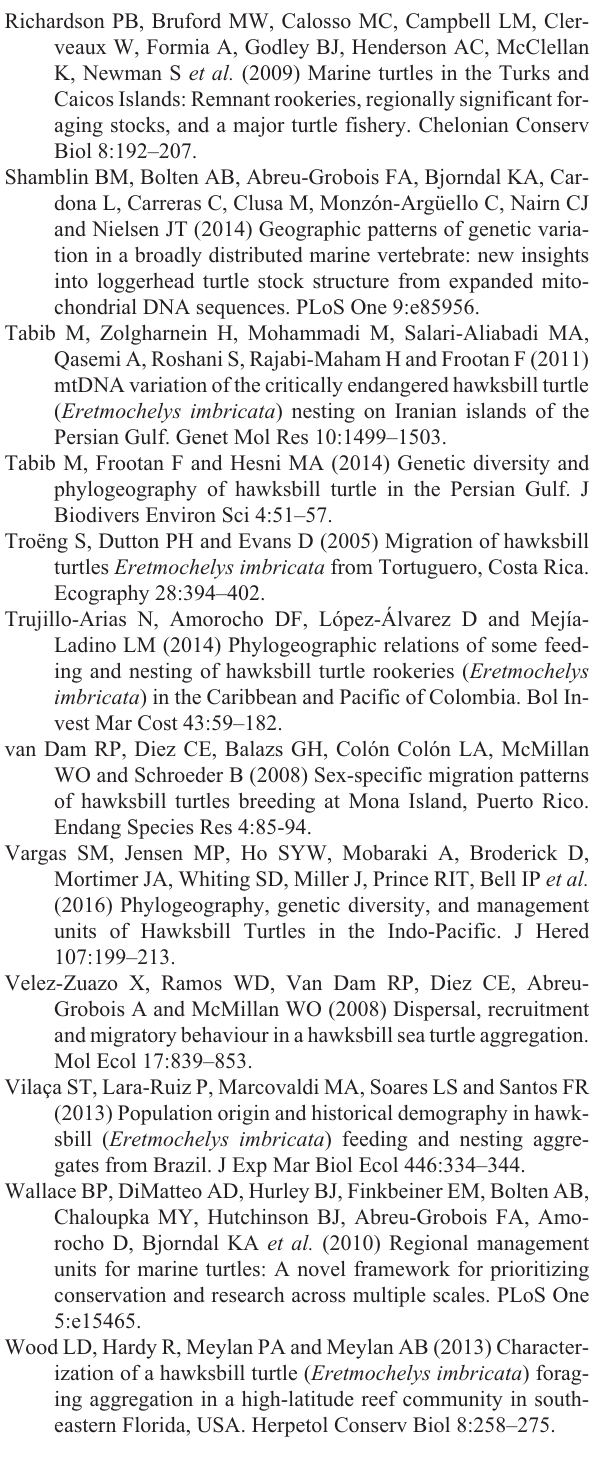
Table S5 - F-statistics (FSC, FCT, and FST) associated to the K groups calculated using mtDNA control region of hawk - sbill turtles from Indo-Pacific